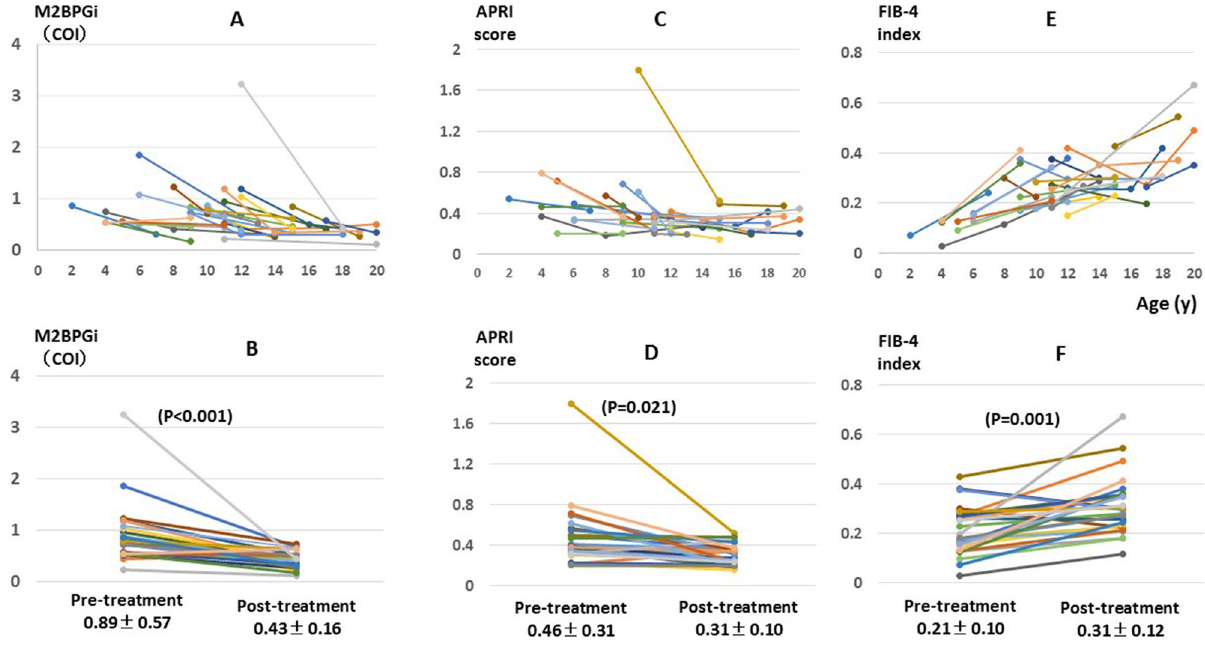
Figure 3. Change in M2BPGi, APRI and FIB-4 levels by treatment. In A , C , E dots indicating M2BPGi levels were plotted at age in years when measurement of M2BPGi was done. M2BPGi dots at pretreatment and at posttreatment are connected for each child in all six